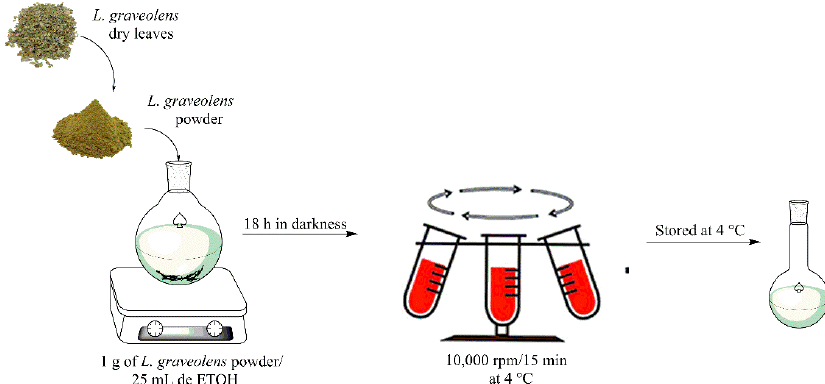
Figure 1. Schematic representation for free phenolic compounds extraction.